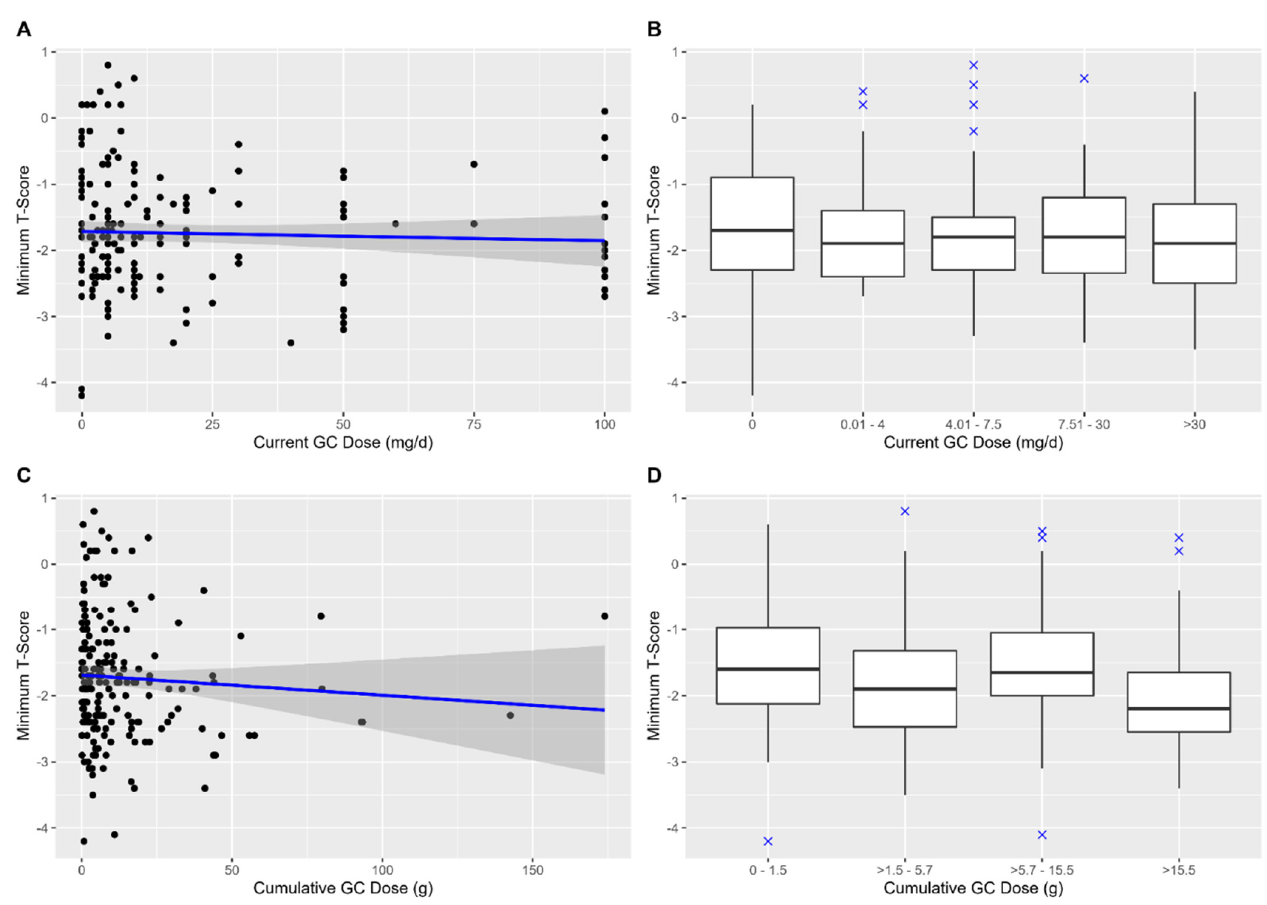
Figure 1. Scatter plots ( A ) and ( C ) and boxplots ( B ) and ( D ) of minimum T-scores and glucocorticoid (GC) intake. All plots: patients with a disease duration of <3 months were excluded. Plot A: patients with a current dose of >100 mg/d were excluded. In ( A ) and ( C ), the straight blue line represents a hypothetical regression line, accompanied by its 95% confidence interval (dark grey shadow).